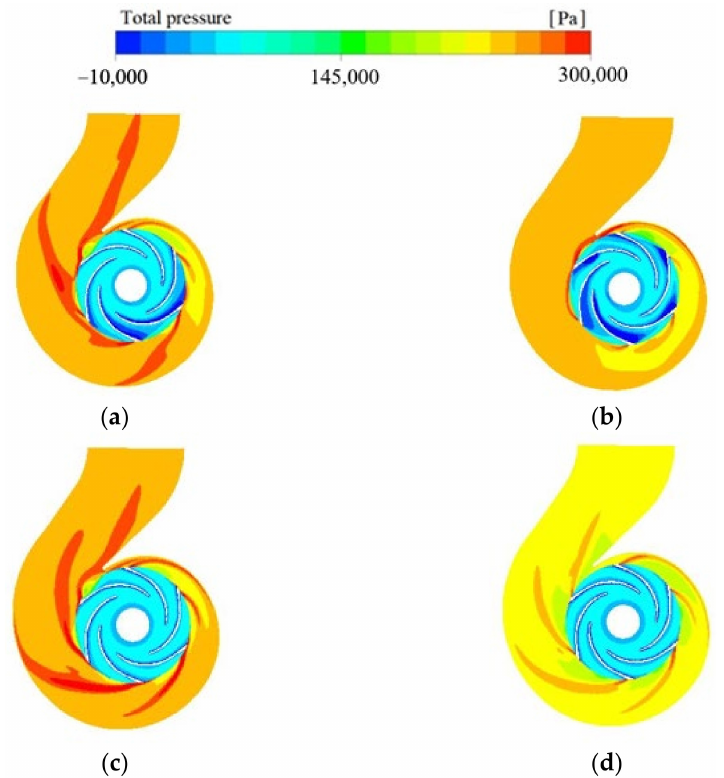
Figure 10. The total pressure in pump cross-section at different flow rates: ( a ) 800 m 3 /h; ( b ) 1000 m 3 /h; ( c ) 1100 m 3 /h; ( d ) 1300 m 3